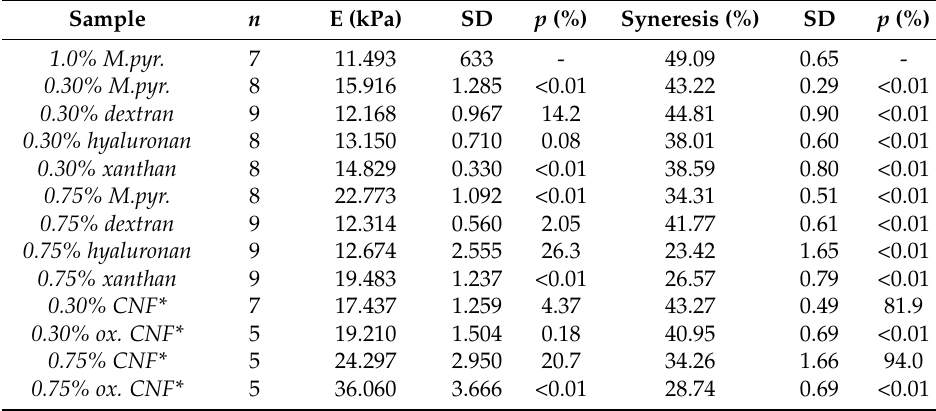
Table A5. Statistical outcomes, Figure 4A,B: E = Young’s modulus, standard deviation (SD), number